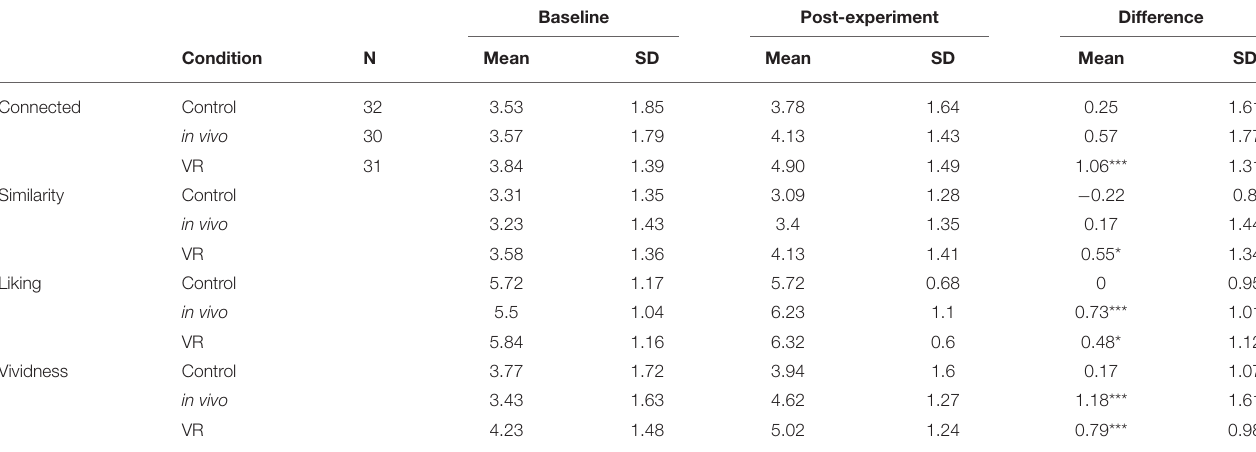
TABLE 1 | Means, standard deviations, and difference scores between baseline and post-experiment of the domains of future self-continuity. Baseline Post-experiment